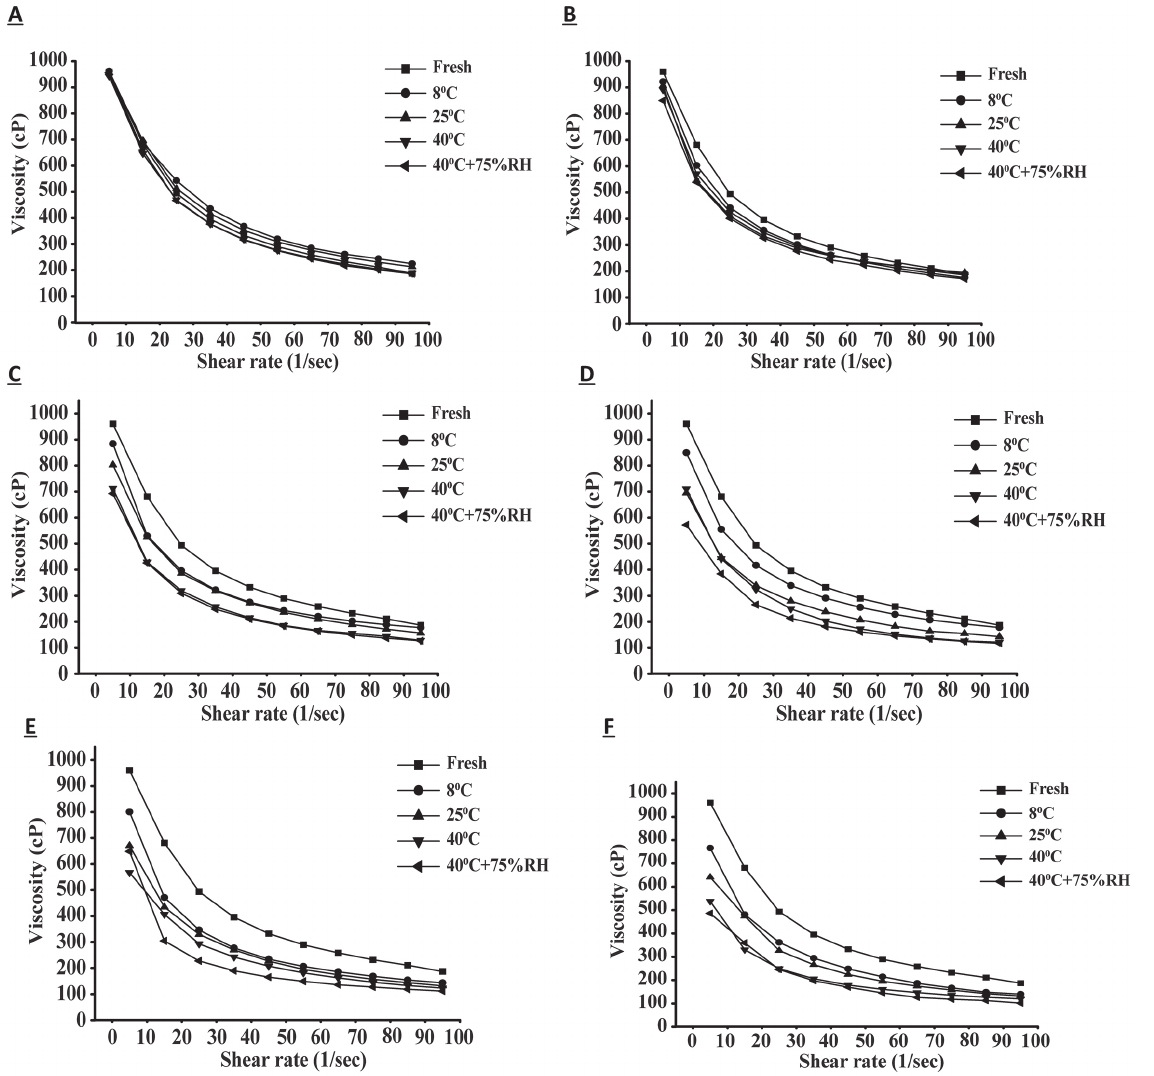
FIGURE 6 - Consistency evaluation of CT emulgel representing rheograms of viscosity v/s shear rate at different temperature and time, (A) viscosity v/s shear rate of CT emulgel at 1-day, (B) viscosity v/s shear rate of CT emulgel at 7-day, (C) viscosity v/s shear rate of CT emulgel at 15-day, (D) viscosity v/s shear rate of CT emulgel at 30-day, (E)viscosity v/s shear rate of CT emulgel at 60-day, and (F) viscosity v/s shear rate of CT emulgel at 90-day.